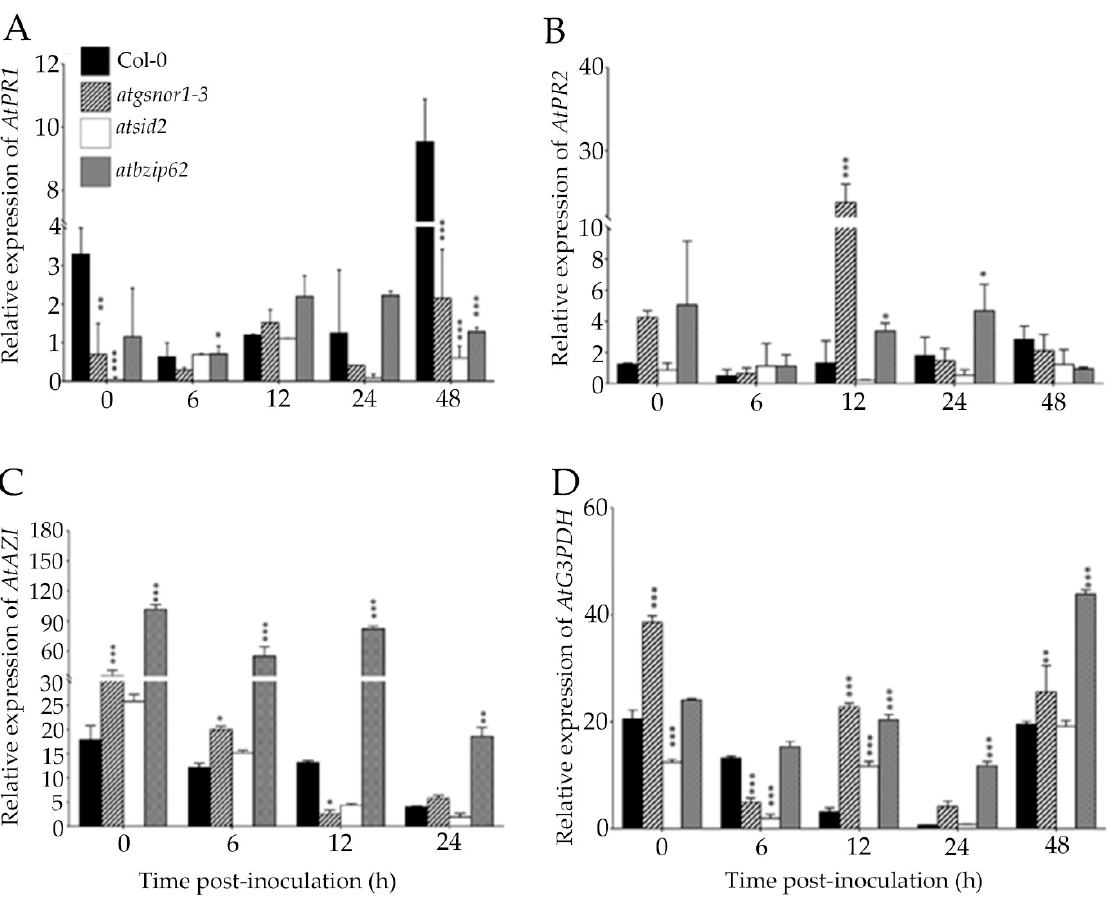
Figure 3. AtbZIP62 negatively regulates SAR. Transcript accumulation of ( A ) AtPR1 , ( B ) AtPR2 , ( C ) AtAZI , and ( D ) AtG3DPH genes in the systemic leaves of Col-0 (WT), atgsnor1-3 , atsid2 , and atbzip62 mutant lines under Pst DC3000 avrB inoculation. Data are the mean expression values in triplicate normalized to the relative expression of AtActin1. * p < 0.05; ** p < 0.01; *** p < 0.001; empty are non ‐ significant.